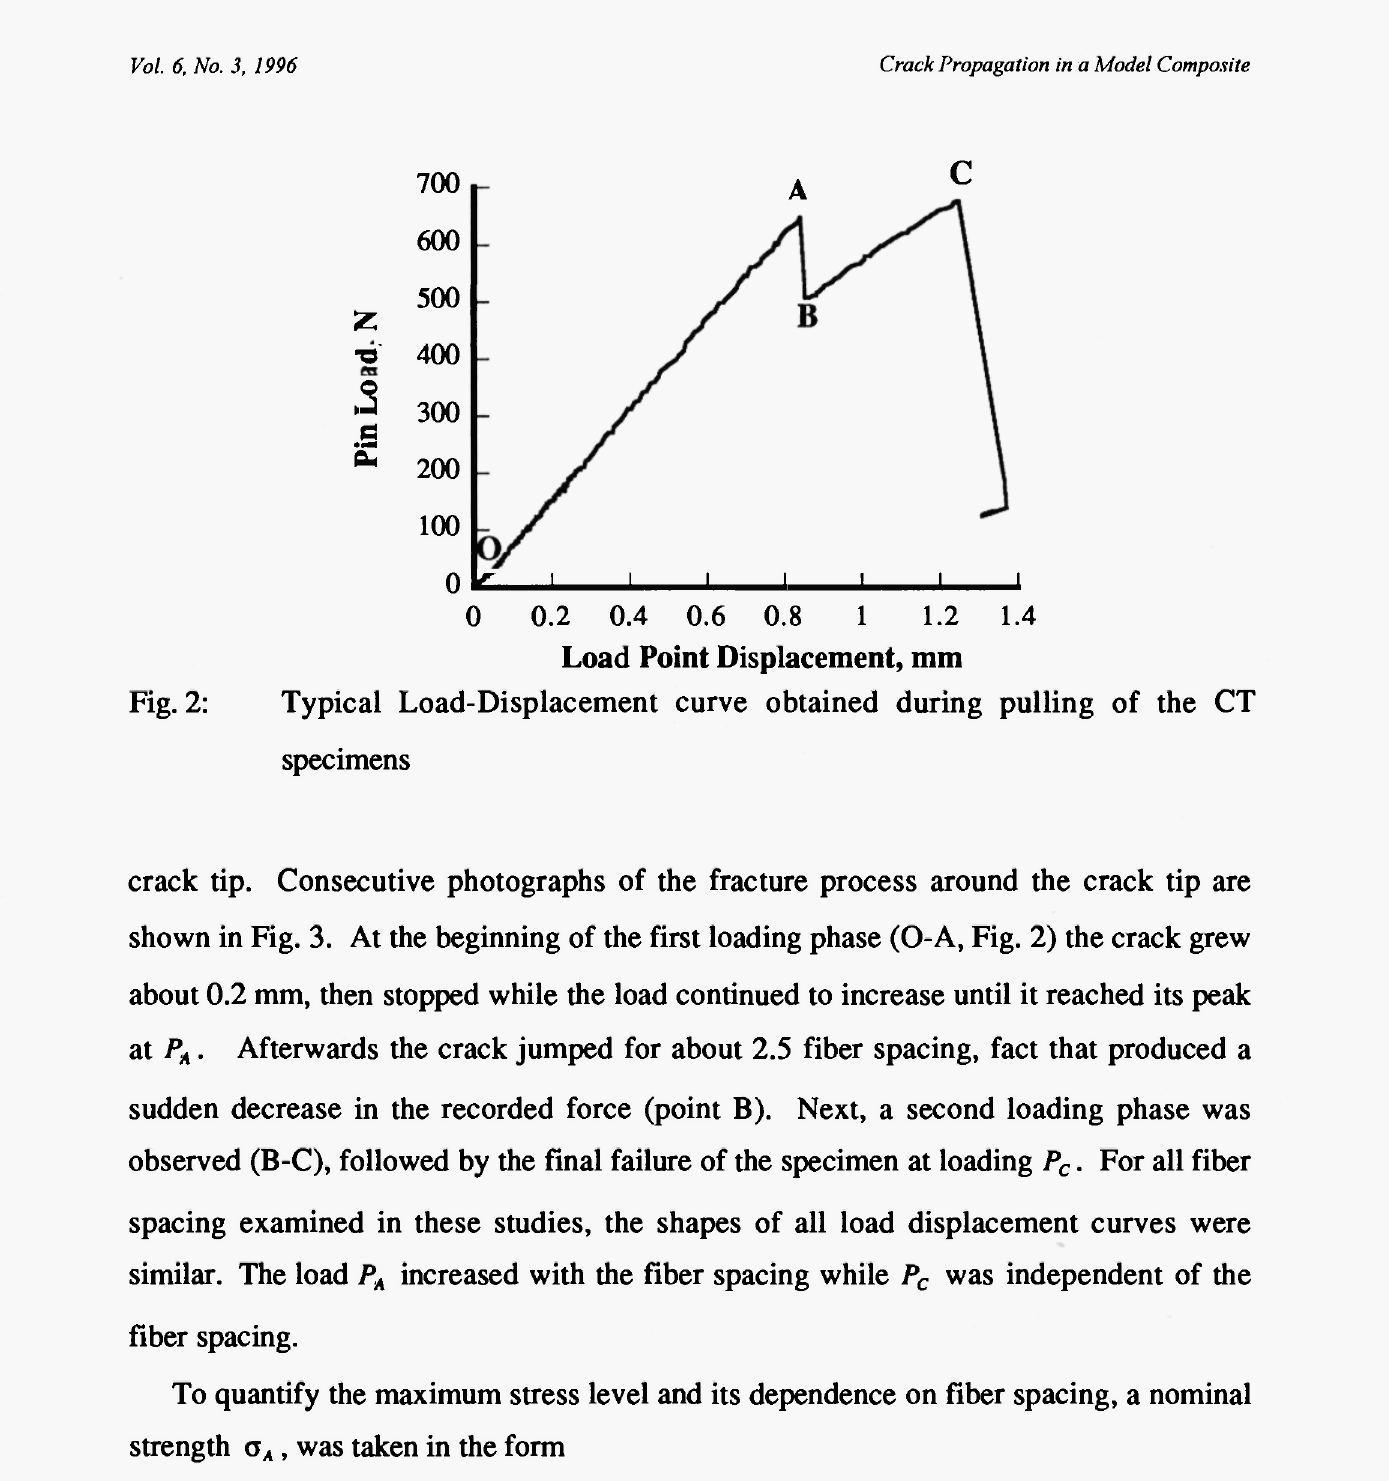
Fig. 2: Typical Load-Displacement curve obtained during pulling of the CT